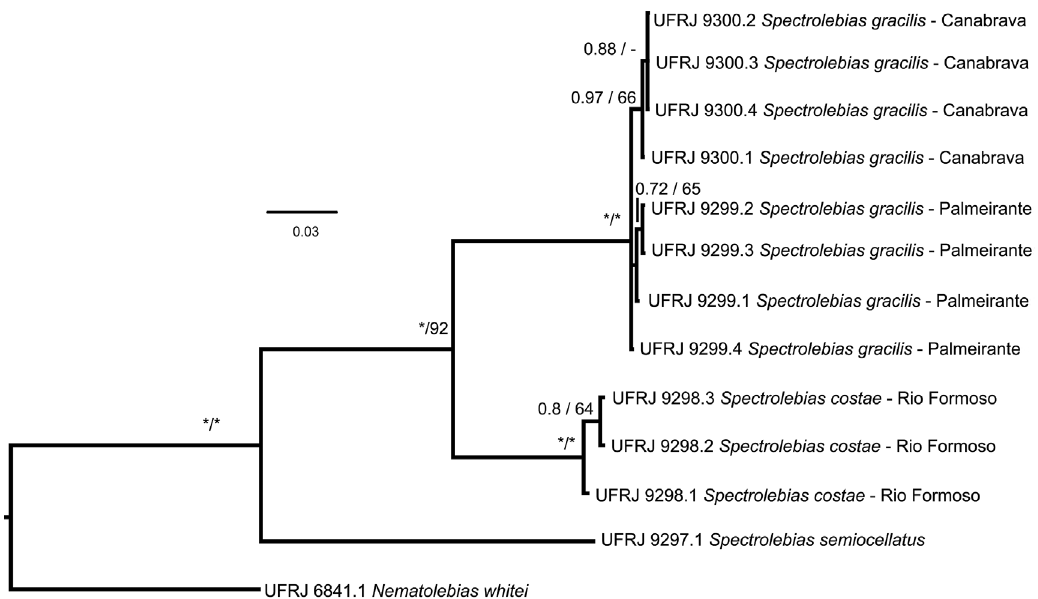
Figure 1. Bayesian phylogenetic tree for Spectrolebias costae sp. n., S. gracilis , S. semiocellatus and Nematolebias whitei . Numbers above nodes are support values, including posterior probabilities for the Bayesian analysis, followed by bootstrap percentages for the maximum likelihood analysis; *, means maximum support value and, bootstrap value below 50.